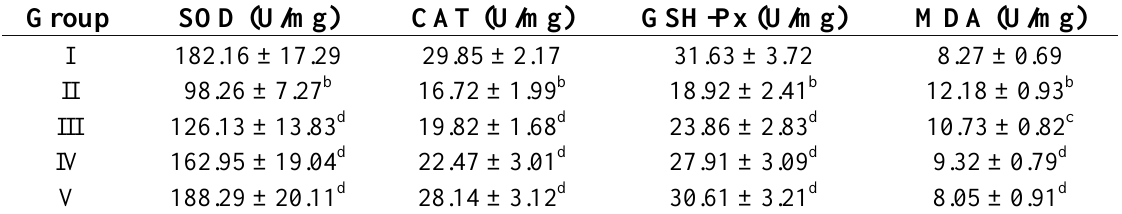
Table 2. Effect of Lycopene treatment on blood SOD, CAT, GSH-Px activities and MDA level in gastric cancer